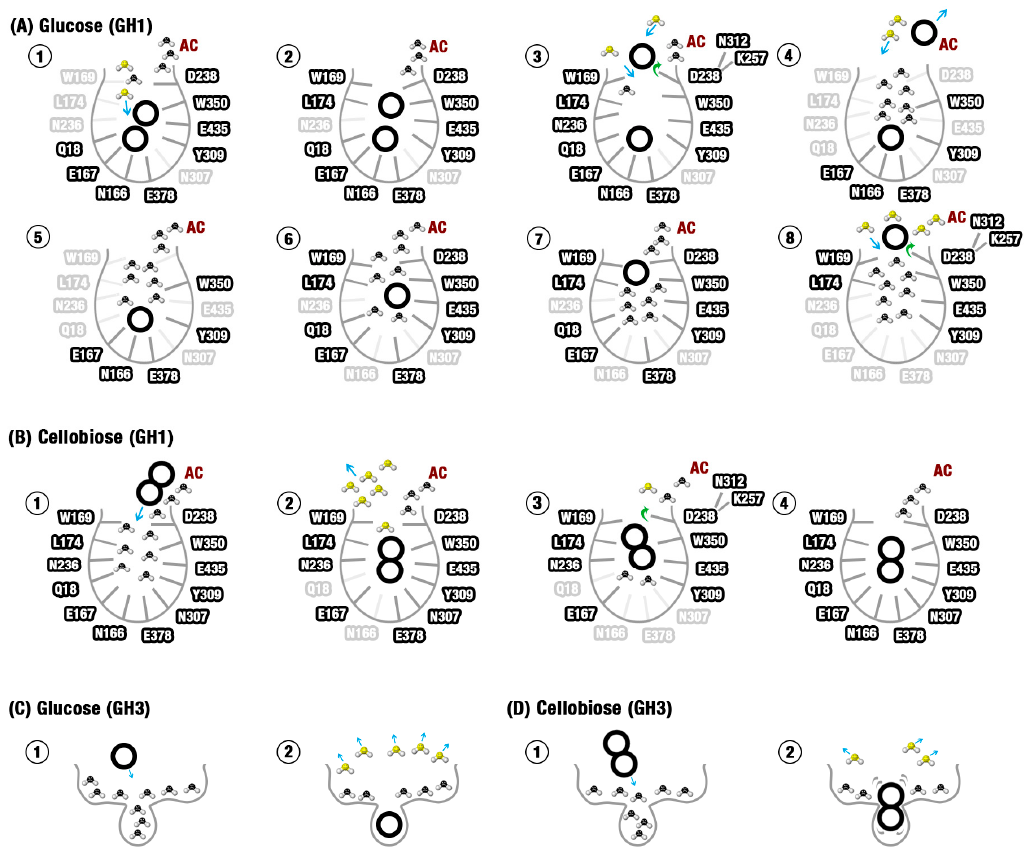
Figure 7. The sequence of molecular events that lead to glucose tolerance at the GH1 enzyme and inhibition at the GH3. ( A ) Slingshot mechanism influences the glucose tolerance of the HiBG GH1